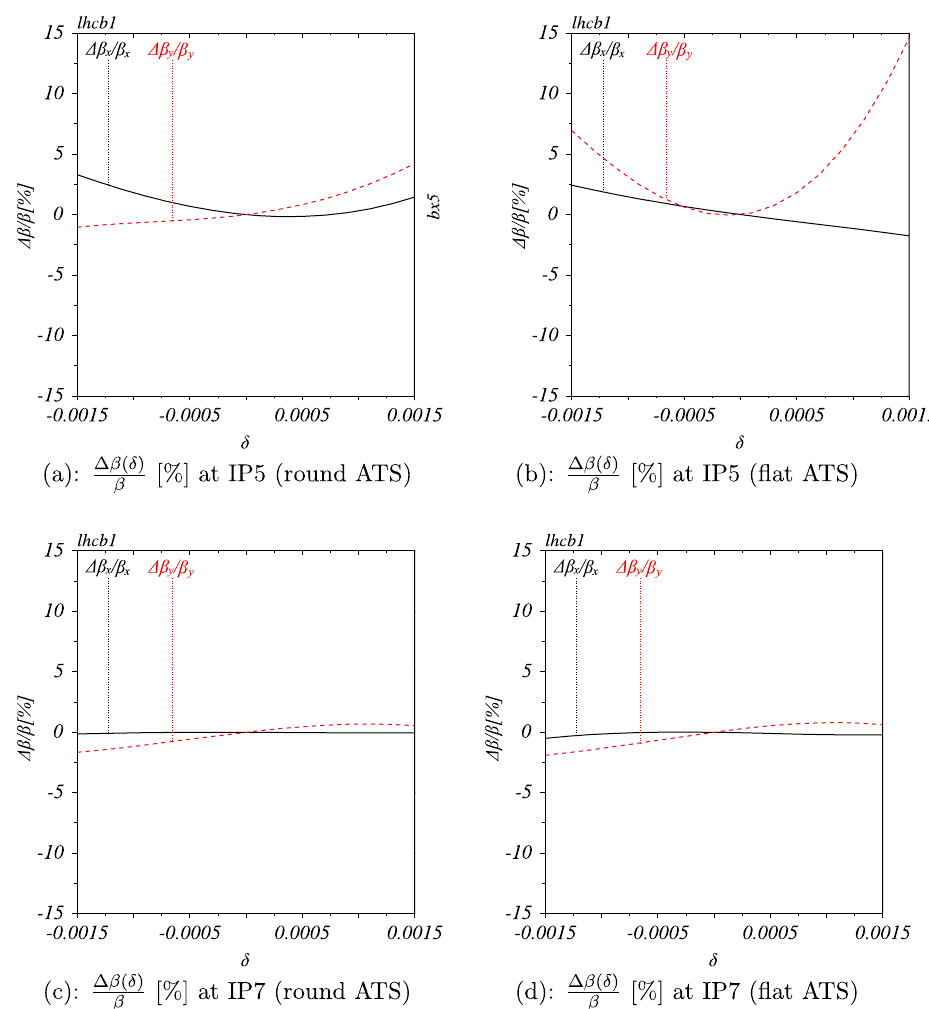
FIG. 10. Chromatic variations of the (cid:1) functions [%] at IP5 (top) and IP7 (bottom) for the telescopic round (left) and flat (right) optics considered in Fig.